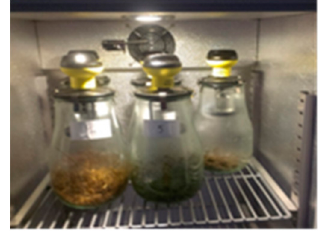
Figure 1. Test stand—the AT4 test.